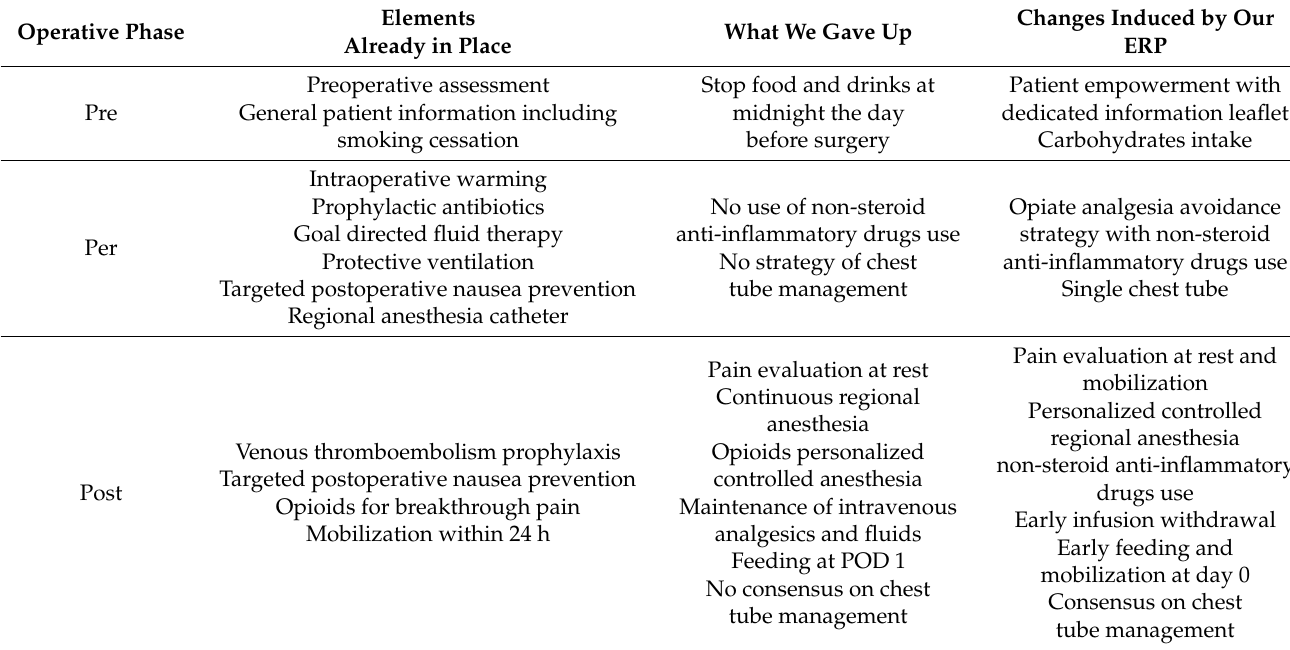
Table 1. Implementation of our thoracic surgery enhanced recovery